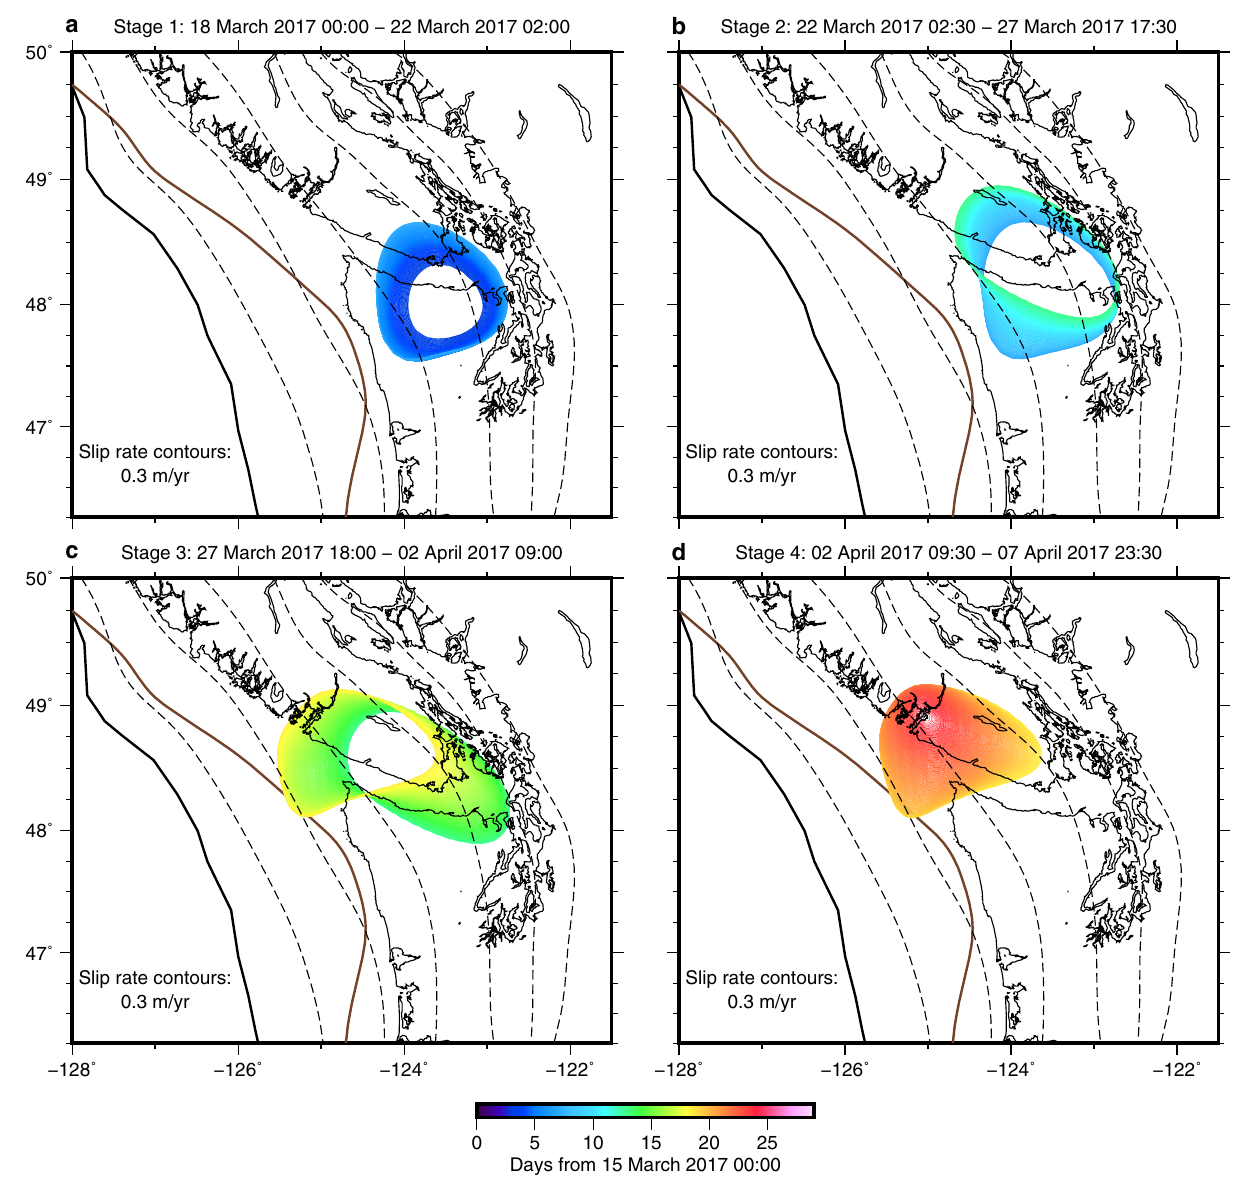
Figure 6. Spatiotemporal slip propagation drawn as collection of slip rate contours of the same slip rate (0.3 m/yr) during four stages as labelled. Collection of slip rate contours of 0.3 m/yr at a 30-min interval is colour- coded with